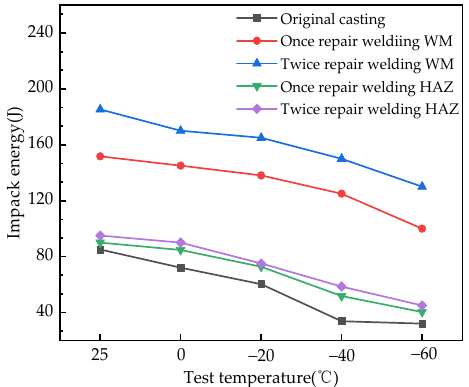
Figure 10. Impact energy in different areas of welded